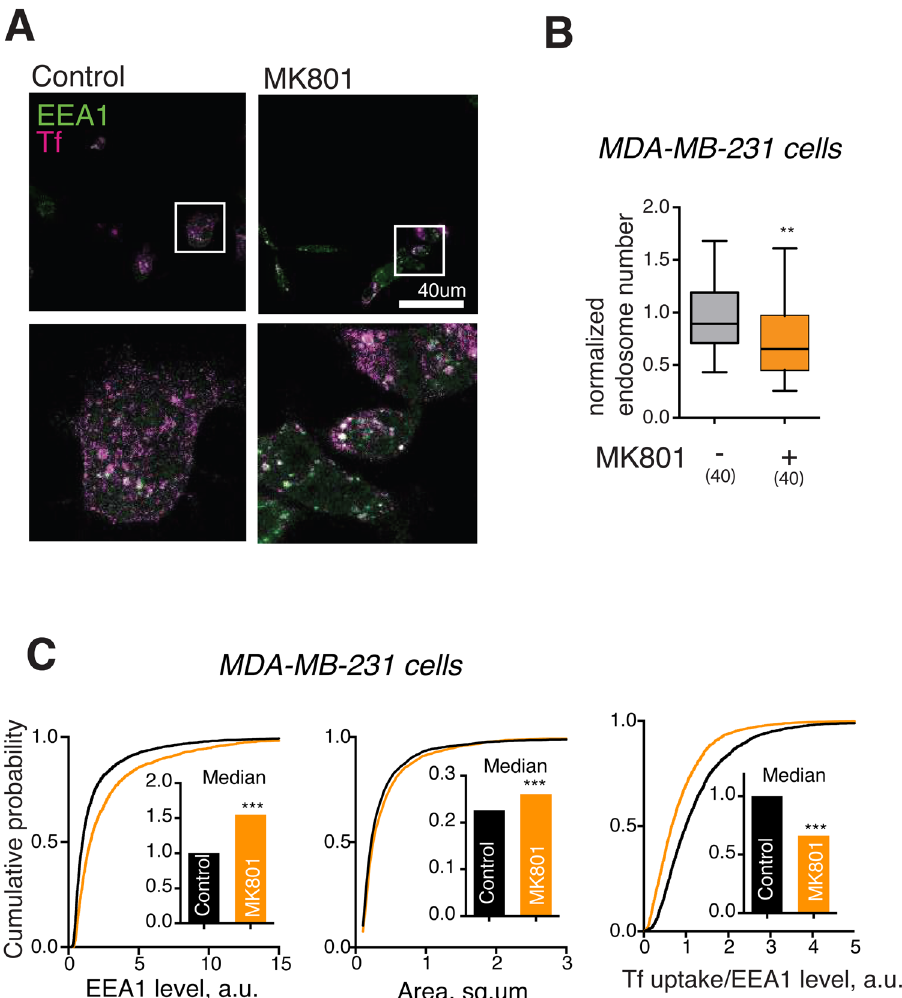
Figure 3. Aberrant regulation of EE structure by NMDARs in a cancer cell line. ( A ) Representative image of MDA-MB-231 cells incubated with fluorescent Tf in presence of MK801 for 30 min. N = 4 independent experiments. ( B) Normalised endosome number per a MDA-MB-231 cell following MK801 treatment for 30 min. ** P < 0.01, Mann-Whitney U test, 40 cells/condition, 4 independent experiments. ( C) Effects of MK801 treatment on EE area, EE-specific EEA1 levels, EE-specific Tf/EEA1 ratio. P < 0.0001, Mann-Whitney U test. N = 50–200 EEs/image, 25 images/condition, 5 independent